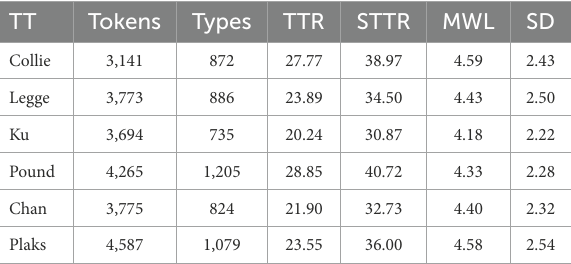
TABLE 3 Lexical statistics of the six TTs.